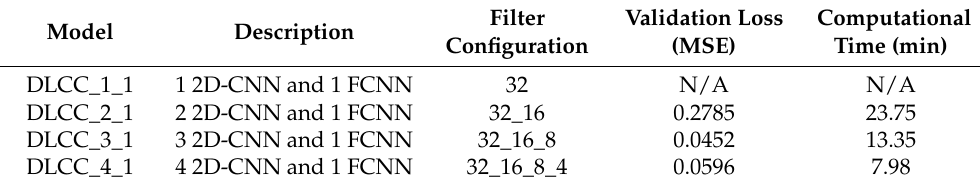
Table 2. Comparison of the different model depths of DLCC.